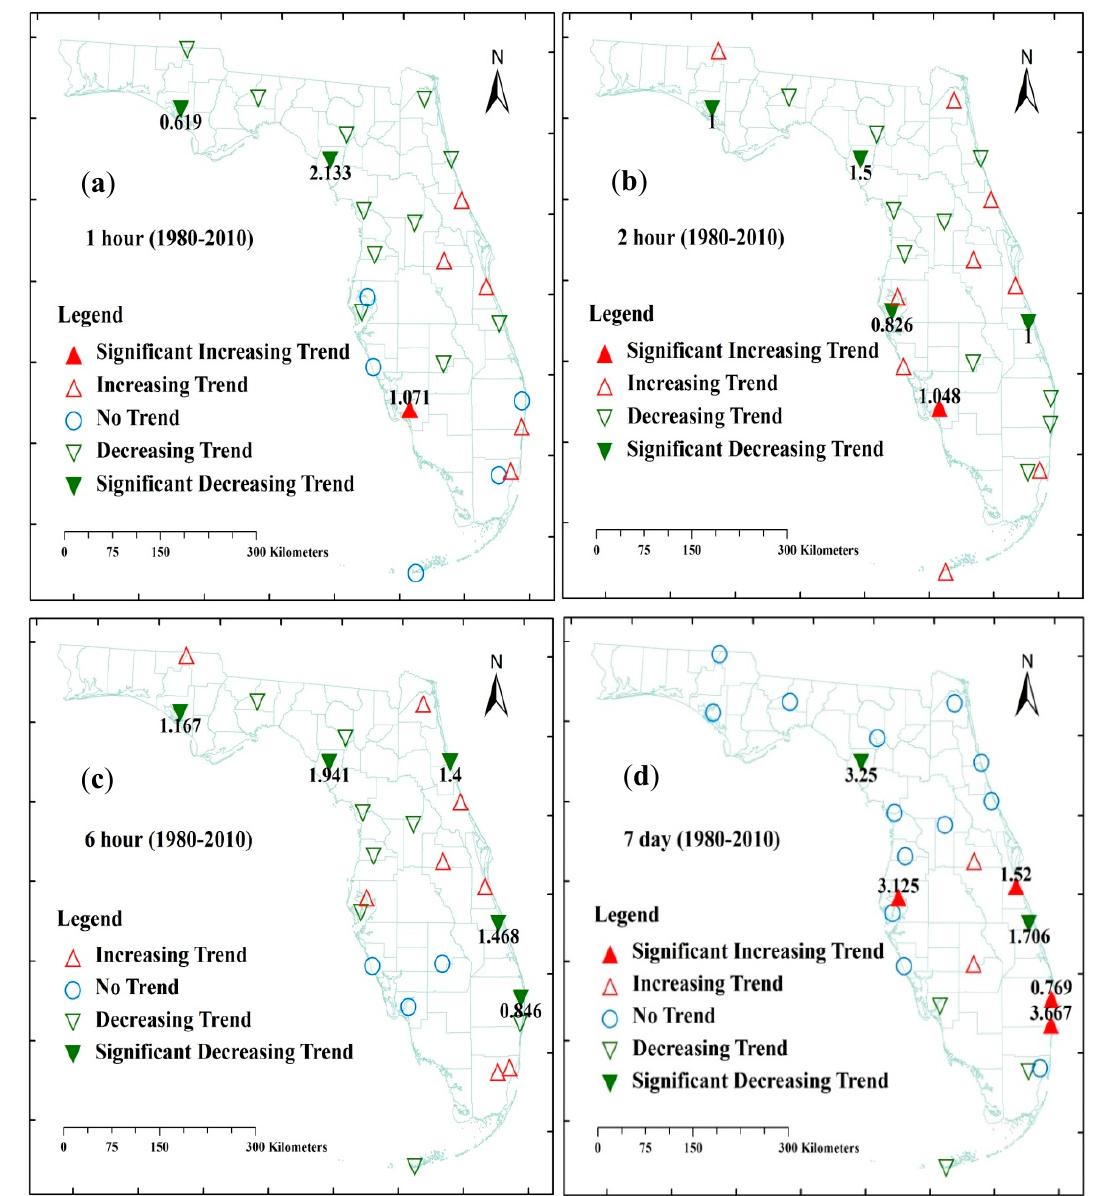
Figure 6. Spatial pattern of the trend results for the annual number of above-threshold events for ( a ) 1 h, ( b ) 2 h, ( c ) 6 h, and ( d ) 7 day rainfalls during the 1980–2010 analysis period. The slope value (events/year) for locally significant trend is also indicated.